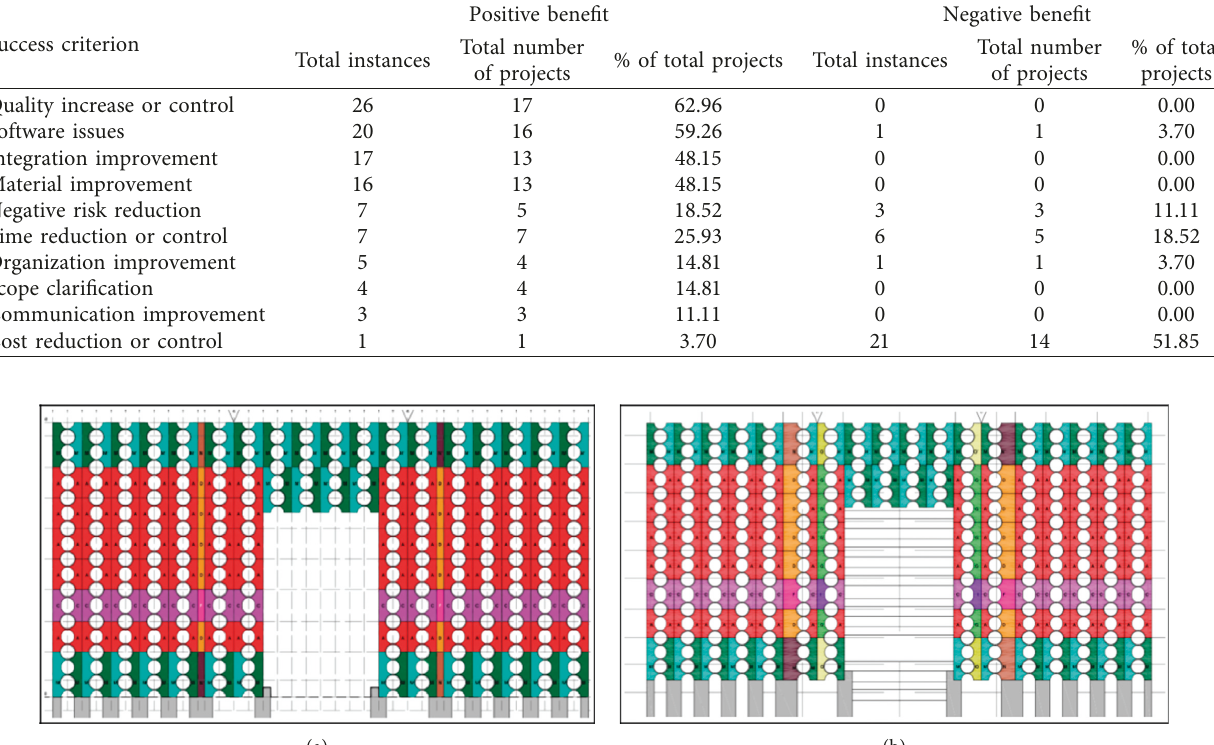
Figure 2: Design optimization for exterior cladding. (a) Original design with 12 types of formwork and (b) optimized design with 8 types of formwork.